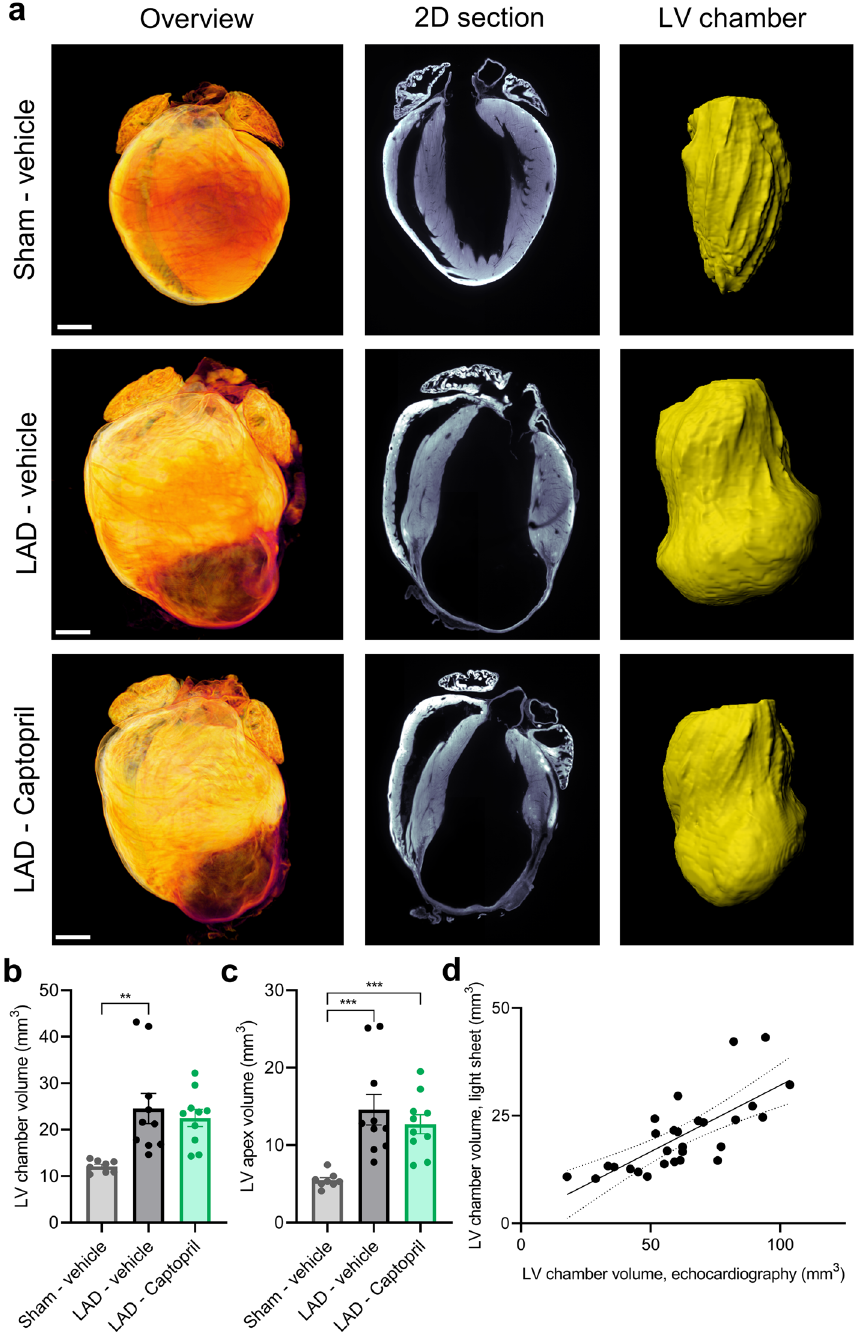
Figure 2. Light sheet imaging and automated analysis of myocardial infarction. ( a ) Representative examples of light sheet imaged hearts. 3D overview image is shown on the left. Second panel from left—digital 2D section is taken from 3D reconstructed heart (long axis horizontal plane). Third panel from left demonstrates deep learning-based segmentation of the left ventricle (LV) chamber (in yellow). ( b ) Diastolic LV chamber volume quantified by deep-learning based analysis. ( c ) LV apex volume (quantified below plane fitted through the center of deep learning segmented chamber). ( d ) Light sheet quantification of LV chamber volume in diastole correlates with echocardiography-based LV end-diastolic volume (r = 0.73, p < 0.0001). Data is presented as mean ± s.e.m., n = 8–10. One-way ANOVA with Tukey’s post hoc test. Significance: **p < 0.01, ***p < 0.001. Scale bars: 1 mm. LAD: left anterior descending artery